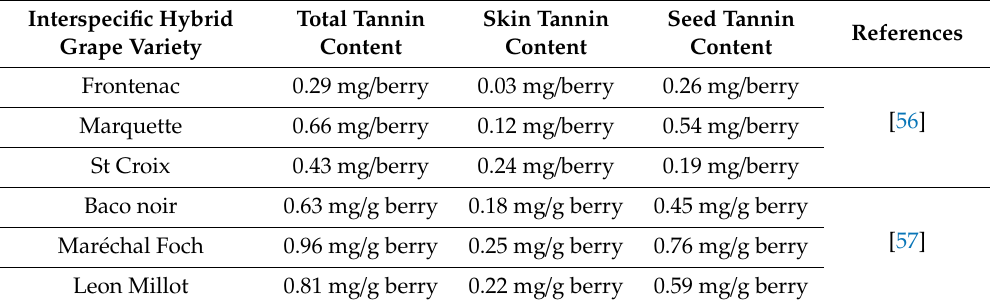
Table 2. Tannin concentration in grape skin and seed of interspecific hybrid grapes, expressed as mg / g berry or mg / berry ( + )-catechin